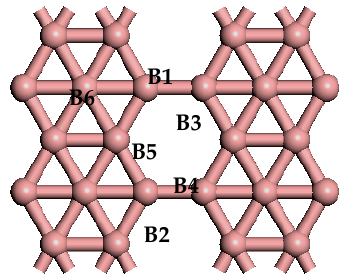
Figure 1. The optimized atomic structure of pure β 12 -borophene. The alphanumeric characters on the graph represent the corresponding atoms.